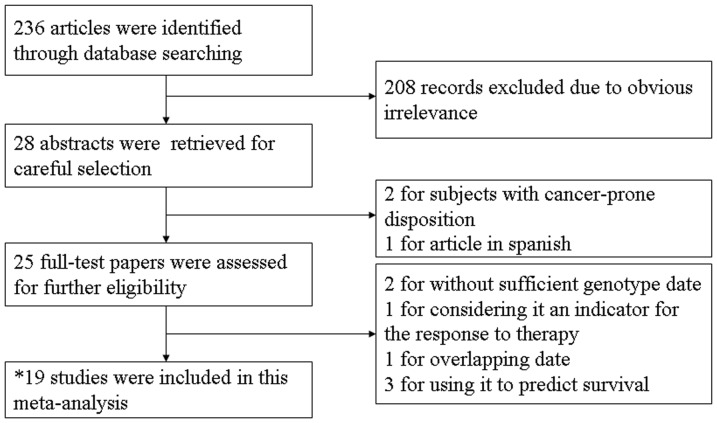
Flow diagram of the study selection process.*a total of 18 articles were identified and two types of cancers were reported in one article, we extracted data separately for each cancer, thus 19 studies were eligible.